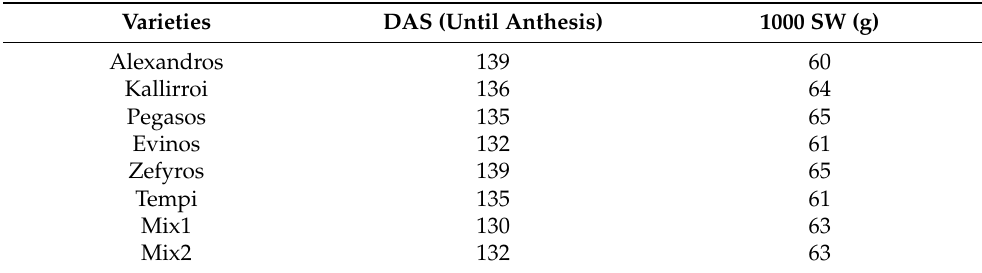
Table 2. Days after sowing (DAS) until anthesis and 1000 seed weight for each cultivar and cultivar mixture according to breeders’ official description. Varieties DAS (Until Anthesis) 1000 SW